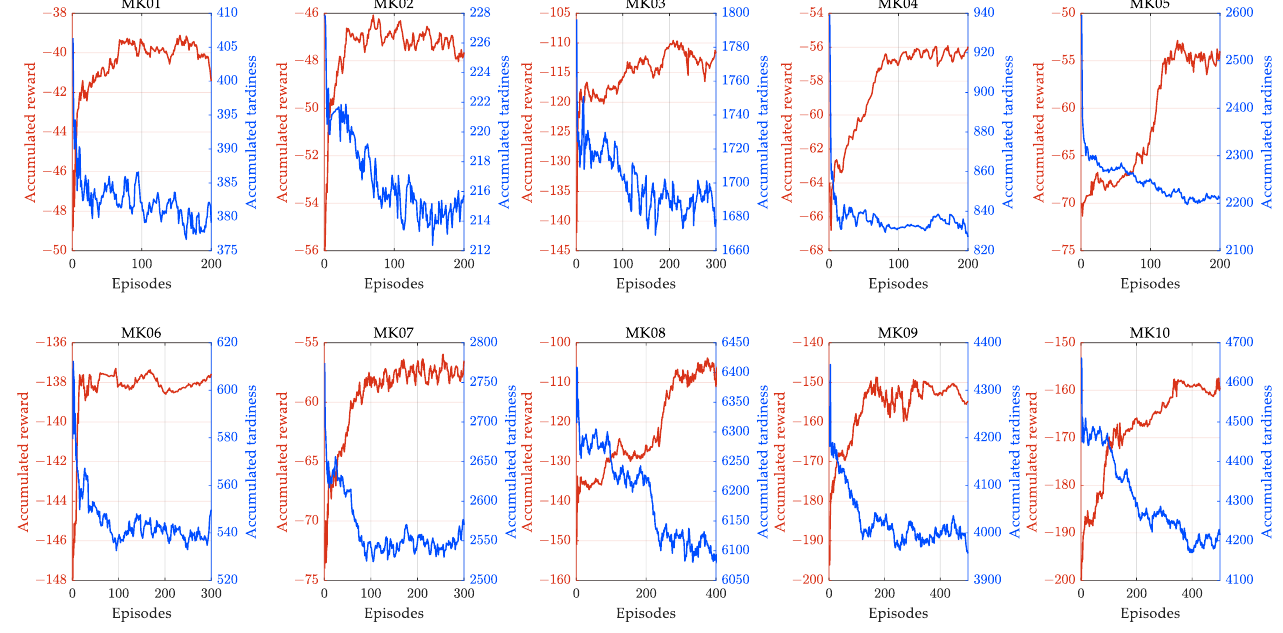
Figure 10. Convergence curve of global reward and tardiness.